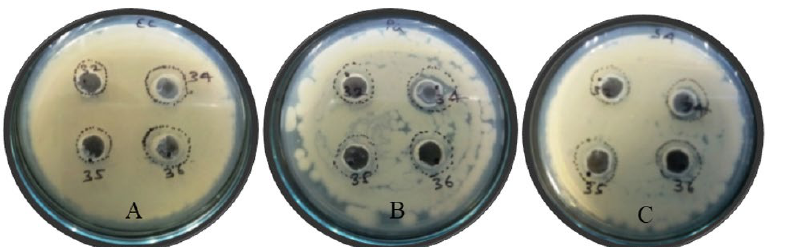
Fig. 1(a). Screening bacterial isolates for antibiosis activity by well diffusion method against (A) E. coli (B) P. aeruginosa (C) S. aureus.